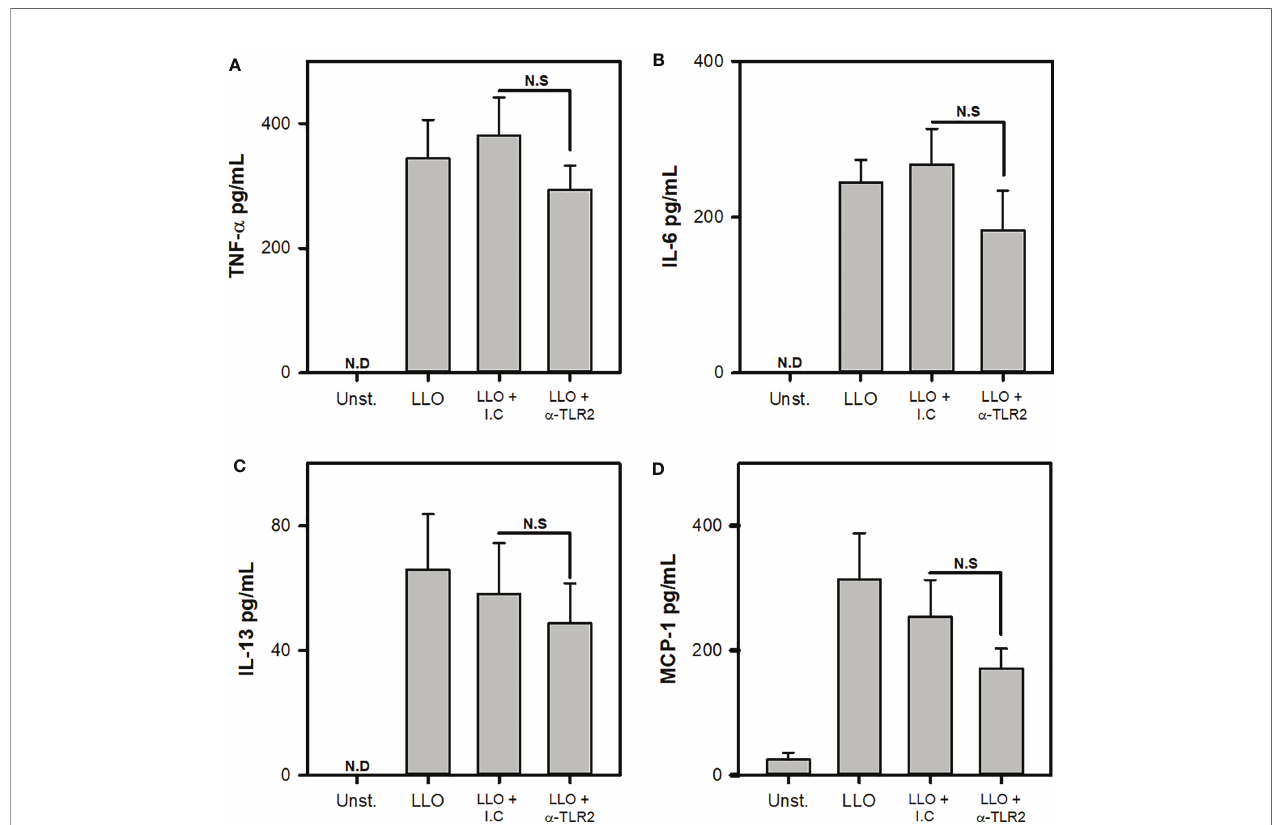
FIGURE 7 | Cytokine production by mast cells in response to Listeriolysin-O is independent of TLR2. 2.5x10 5 BMMC/0.25 mL of complete medium were preincubated with anti-TLR2 for 30 minutes and then were stimulated with 1000 ng/mL of Listeriolysin-O (LLO) for 24 h. Mediators levels were evaluated in culture supernatants by ELISA. (A) TNF- a , (B) IL-6, (C) IL-13 and (D) MCP-1. (Sum of 4 independent experiments, n=4 per group and for each mediator; N.D, Not detected; N.S, Not Signi fi cance; One Way ANOVA